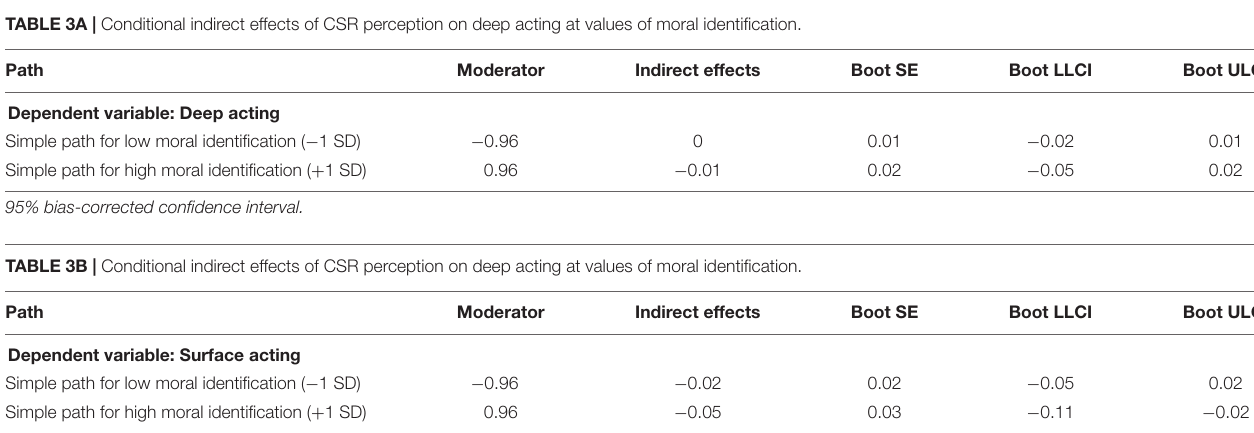
Frontiers in Psychology |